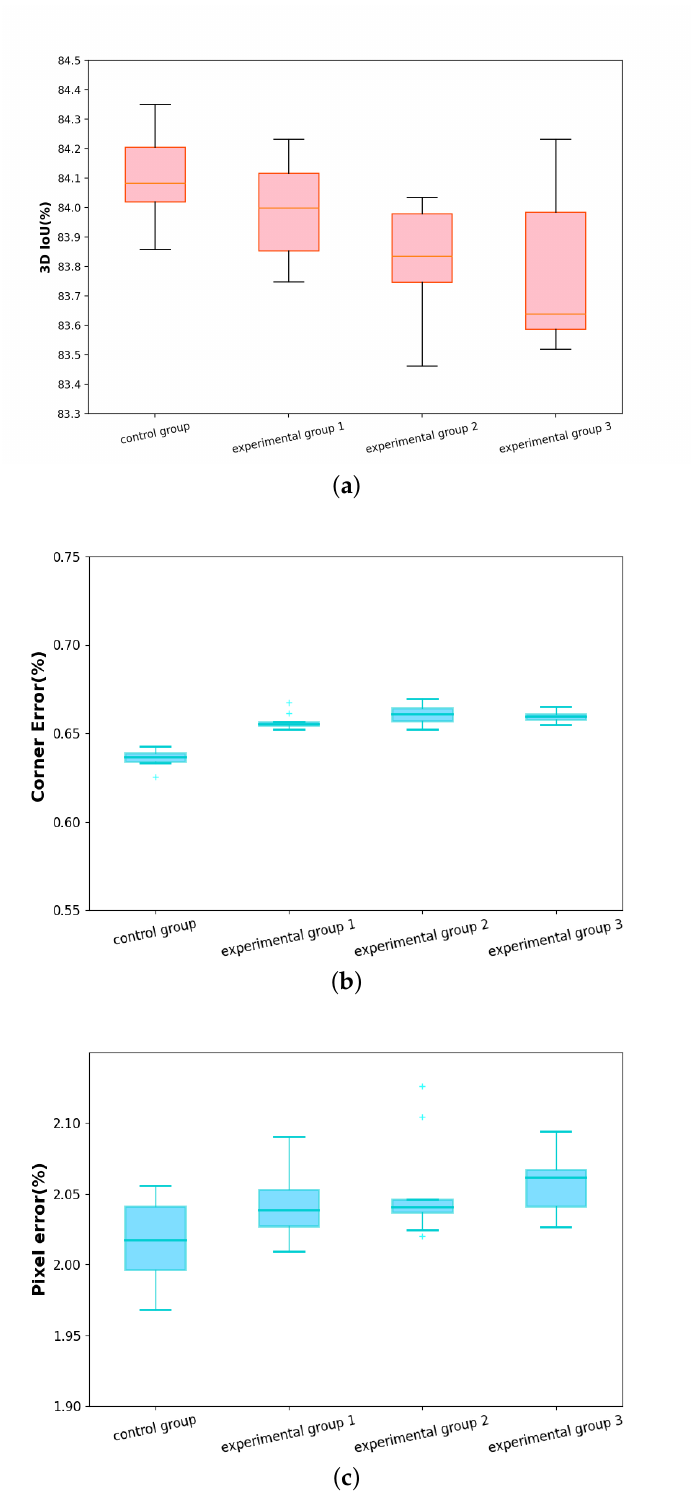
Figure 5. Ablation study for MreNet . ( a ) is for 3D IoU , ( b ) is for corner error ( CE ) and ( c ) is the result of pixel error ( PE